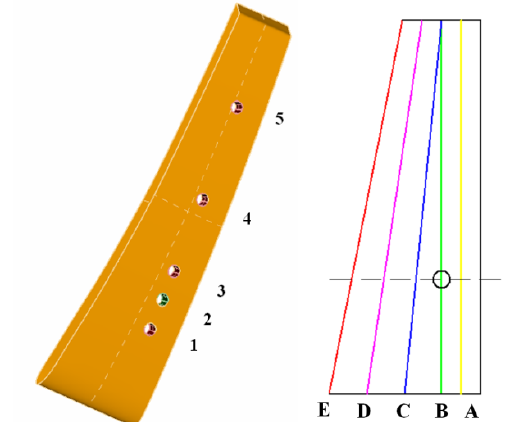
Fig. 5. Positions of holes in investigated variants